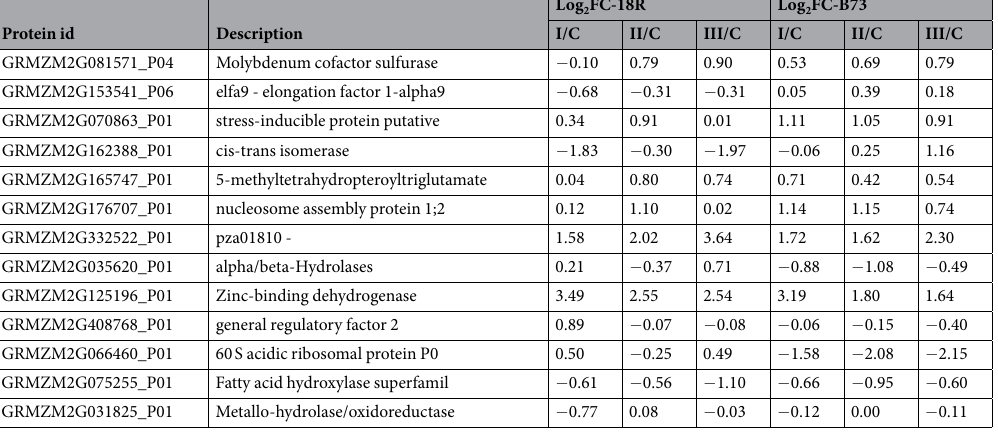
MEmagenta and MEtan were merged and renamed as cluster 5 (C5). MEsalmon and MEpurple were renamed as cluster 2 (C2) and cluster 4 (C4), respectively. As shown in Fig. 3a, the C1 DEPs in 18R were substantially up-regulated in stage II, and there were no signif- icant changes in stages I and III. However, the DEPs in B73 increased at all 3 stages. These DEPs likely played an important role in the initial EC formation and were not required for stage I or III. In C2, DEPs were up-regulated at 3 stages in 18R and especially increased at stage III, whereas no significantly changes were noted in B73. The DEPs in C3 were sharply up-regulated during all stages in 18R, but not even down-regulated in B73. On the contrary, the DEPs in C5 decreased at stage I and retained a lower level at stages II and III in 18R, but did not significantly change in B73, which suggested that these DEPs are rapid and continuous response factors. The C4 DEPs did not change at stage I, but were extremely reduced at stages II and III in 18R. Still, they were sharply down-regulated at all stages in B73, which suggested that they were needed for embryo enlargement in 18R. To understand the role of differentially expressed genes in EC, the 243 DEPs were submitted to Gene Ontology (GO) enrichment analysis. The top ten GO terms of each cluster are shown in Fig. 3b and c. These molecular functions and biological process GO terms include metal ion binding, oxidoreductase activity, protein bind- ing, RNA binding, lyase activity, hydrolase activity, metabolic processes, response to stimulus and metal ions, oxidation-reduction processes, and organonitrogen compound metabolics (Supplementary Table S6). Interestingly, a total of 69 DEPs in C1, C2, C3, C4 and C5 were enriched for metal ion binding or correspond- ing functions ( P < 0.05, Table 1). Among them, four dehydrogenase family proteins were induced in all of the stages (Table 1). Likewise, three cytochrome family proteins were up-regulated, while two were down-regulated (Table 1). Six peroxidase super family proteins in C1, C2 or C3 (Table 1) were up-regulated in the process of EC formation. These DEPs may function by activating oxygen scavenging. In addition, three DEPs were glutathione S-transferase-like proteins, which are widely known to respond to stimuli or detoxification in scavenging of toxic organic hydroperoxides to protect plants from ROS damage 16 . Similarly, genes involved in energy metabolism were induced at all 3 stages (Table 1 and Fig. 3). Clearly, EC formation is a complex process that requires sufficient energy for fast growth and cell division 17 so that energy metabolism was already identified as important for maize and Arabidopsis callus induction 10 . By GO analysis, 30 DEPs were classified into cell differentiation, division, communication and programmed cell death (Table 2). Although their P values were larger than 0.05, we selected them for further analysis because the process of EC induction does involve cell dedifferentiation, division and re-differentiation. Among them, 4 reduced and 4 increased DEPs were assigned to cell-cell junction or cell communication (Table 2). Meanwhile, 3 increased and 2 reduced DEPs were classified as cell differentiation, and 3 down-regulated DEPs as players in cell division (Table 2). Moreover, GRMZM2G408768_P01 was annotated as a cell cycle regulator, which was up-regulated at stage I in 18R but immediately reduced to normal levels at following stages (Table 2). However, the level of this protein did not increase at stage I and even decreased at stages II and III in B73. In addition, the RNI-like protein superfamily (GRMZM2G393272_P02), including the SART-1 (GRMZM2G109284_P01) and Endochitinase PR4 proteins (GRMZM2G129189_P01) were assigned to the biological processes of meristem development, meristem initiation and somatic embryogenesis, respectively (Table 2). These 3 DEPs of 18R were dramatically increased during all stages; however, they did not significantly change in B73, or the fold-change in B73 was smaller than in 18R (Table 2). Moreover, 4 up-regulated and 5 down-regulated DEPs in 18R (Table 2) were predicted as plant-type cell wall related genes, which were required during cell division. KOBAS (http://kobas.cbi.pku.edu.cn/home.do) was used to perform pathway analysis. Similar to GO analy- sis, energy metabolism-related pathways were identified (Table 3), which suggested that EC induction required a lot of energy. As expected, amino acid synthesis and metabolism pathways were also enriched. In addition, hormone-related pathways were identified, such as plant hormone signal transduction, brassinosteroid biosynthe- sis, alpha-linolenic acid metabolism (which participates in jasmonic acid biosynthesis and zeatin